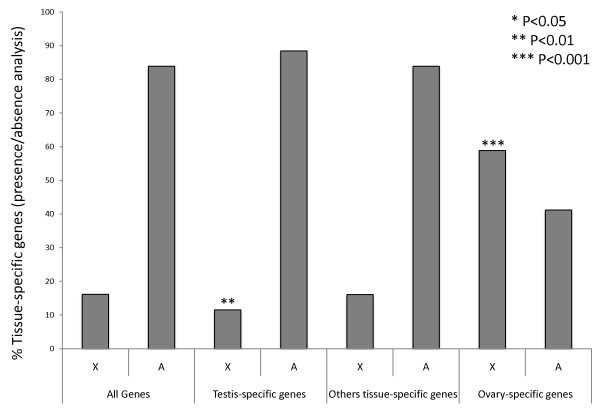
Chromosomal distribution of tissue-specific genes present only in one single tissue. Chromosomal distribution of our own dataset of tissue-specific genes. We required those to be present in a single tissue but completely absent in all other tissues. Testis- and ovary- specific genes are respectively under- and over- represented in the X chromosome (Chi-square test with Yates correction: P = 0.0082, n = 468; P = 0.0001, n = 17, respectively). Other tissue-specific genes were polled together and are not under-represented in the X chromosome (Chi-square test with Yates correction: P = 0.97, n = 118). The sample sizes for individual sets of tissue-specific genes are: accessory glands = 10; head = 37; brain = 20; larval hindgut = 26; larval midgut = 8. Hindgut, midgut, adult carcass, crop, salivary gland, thoracicoabdominal ganglion and larval and adult tubules < 5 (each). Except for brain-specific genes that are over-represented in the X chromosome (Chi-square test with Yates correction: P = 0.01), no other tissue show non-random chromosome distribution (for cases where n ≥4). We analyzed only old genes since the chromosome X is known as enriched with new genes with testis-biased expression. Figure S3 in Additional file 1 show more details for differences between gene age and chromosomal distribution of testis-specific genes.